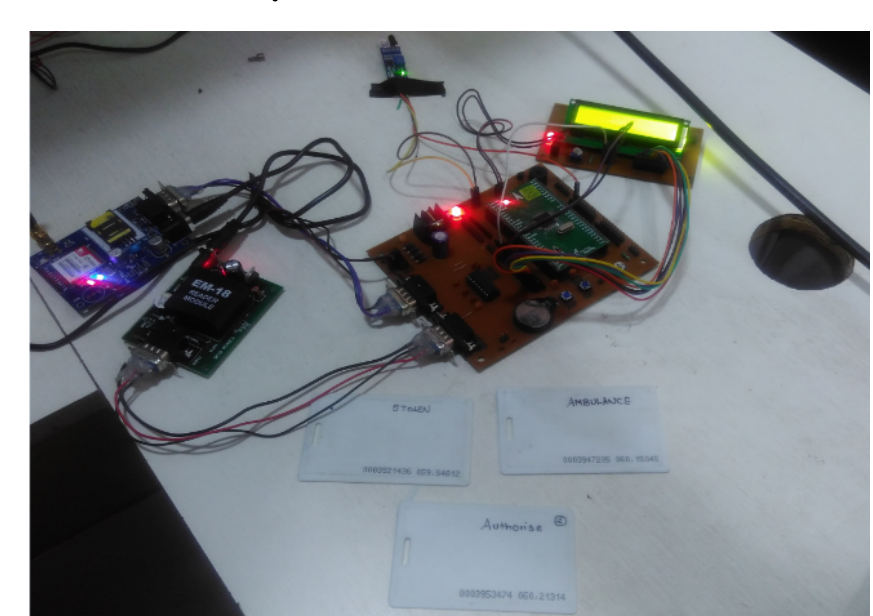
Fig. 6. Actual Circuit Boards